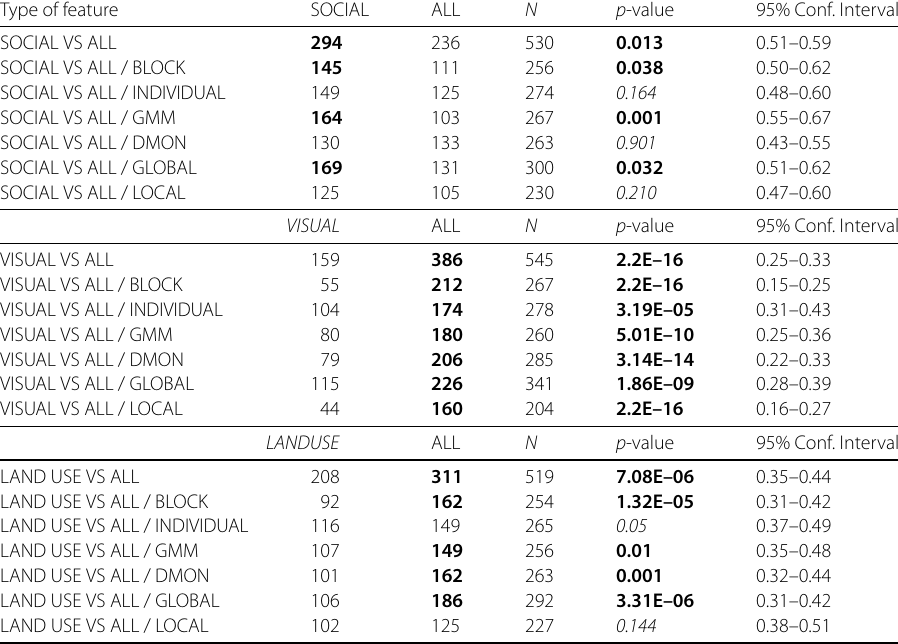
Table 3 Results obtained for type of feature from the survey ∗